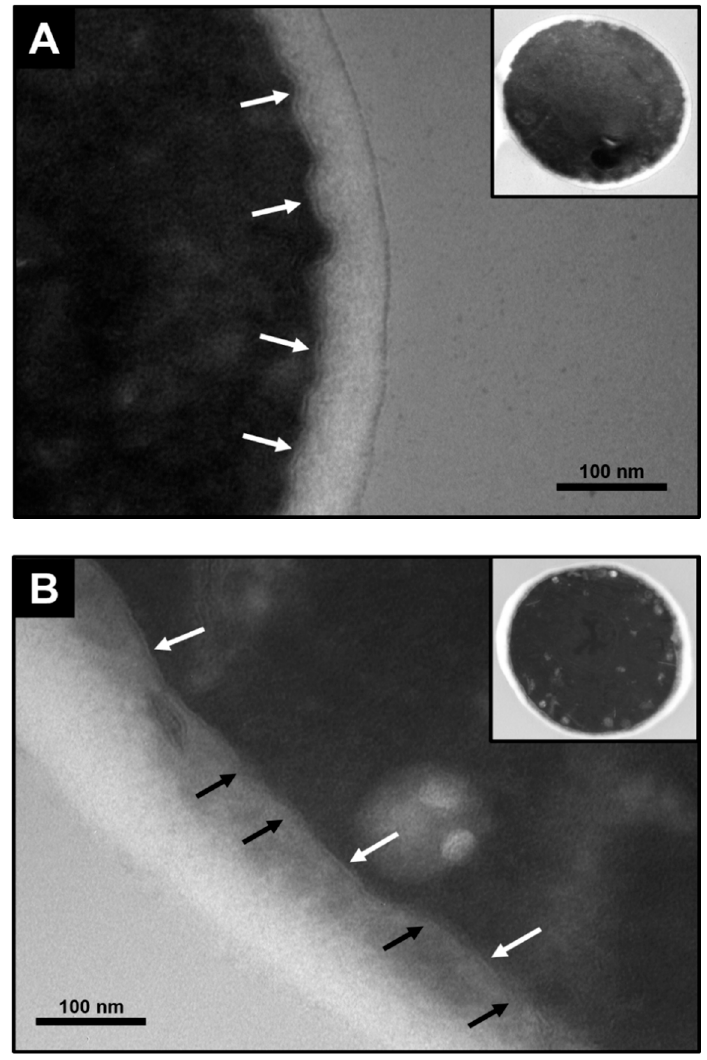
Figure 5. Cell membrane damage in S. cerevisiae EC1118 after exposure for 15 min to a 5.9 GHz at 8 cm from the antennas, using Transmission Electron Microscopy (TEM). ( A ) yeast without treatment. ( B ) yeast treated. White arrows show the membrane integrity (seen as a regular cord surrounding the yeast cytoplasm), while black arrows show regions with membrane damage (seen as loss of membrane continuity). The membrane was observed at a magnification of 135,000 times the regular cell size (~5 µm).